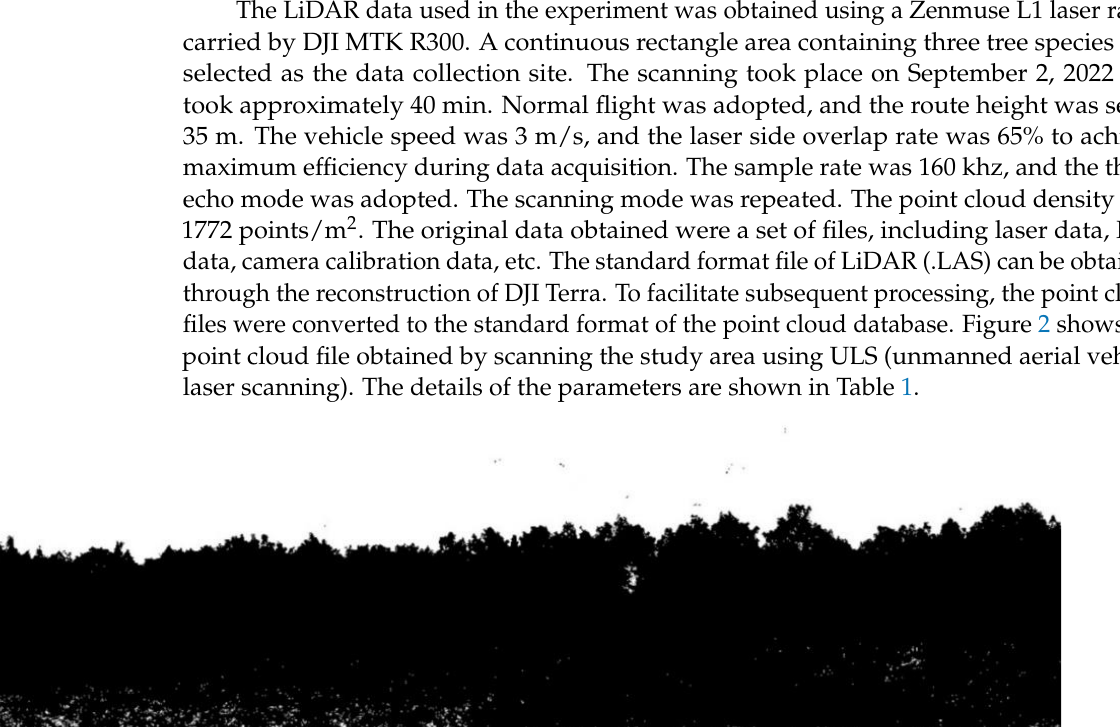
Figure 1. ( a )The location map of the study area; ( b ) aerial view of the study area. Table 1. ULS parameter settings.